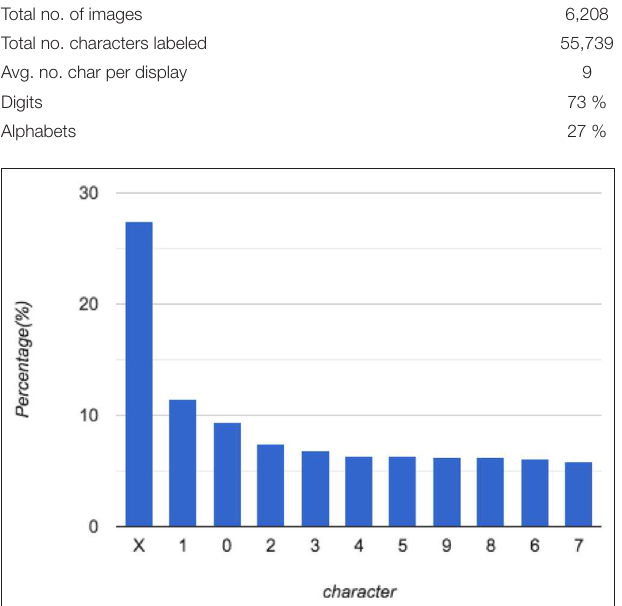
TABLE 1 | Dataset and distribution.